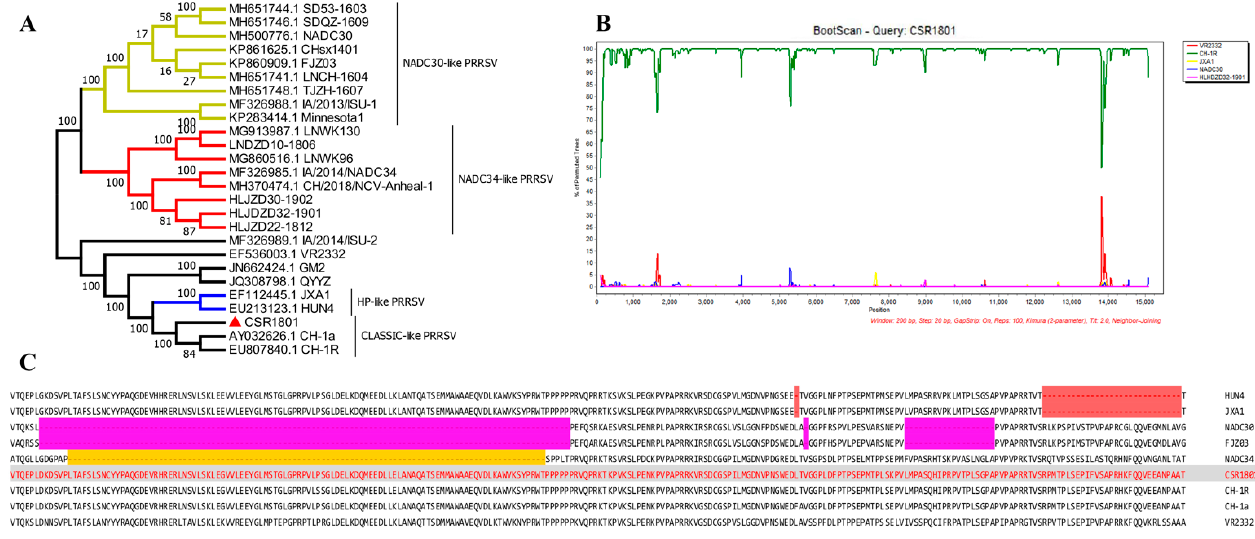
Figure 2. Phylogenetic and recombinant analysis of the PRRSV CSR1801 strain. ( A ) The phylogenetic tree of the whole genome indicated the CSR1801 strain was classified into the CLASSIC ‐ like PRRSV. ( B ) The recombinant analysis between the CSR1801 strain and VR2332, CH ‐ 1R, JXA1, NADC30, and HLHDZD32 ‐ 1901 (NADC34 ‐ like) strains using RDP4 and SimPlot software showed that the CSR1801 strain did not recombine with the other types of PRRSV. ( C ) The alignment of the deduced Nsp2 amino acid sequence between the PRRSV CSR1801 strain and other types of PRRSV strains showed that the CSR1801 strain did not delete any amino acids and was consistent with the CLASSIC ‐ like PRRSV, while it was significantly different from HP ‐ like, NADC30 ‐ like, and NADC34 ‐ like PRRSVs.